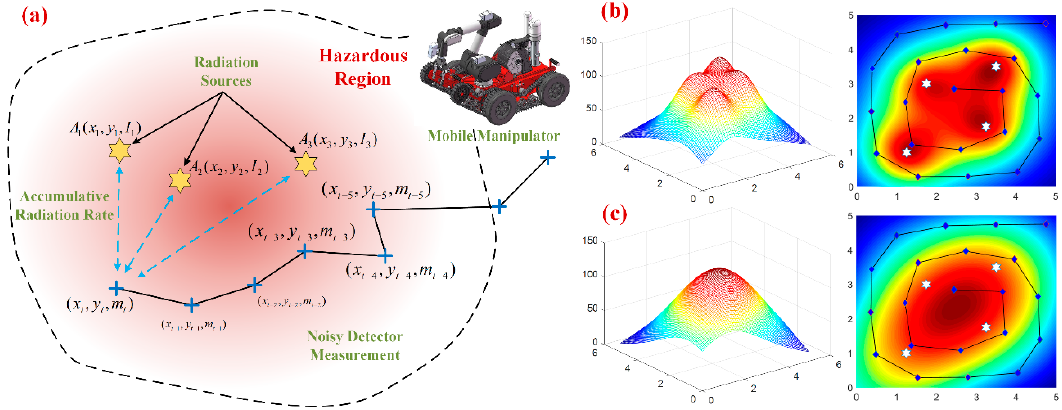
Figure 1. The multi-source radiation scene and problem illustration. ( a ) The scenario illustration of multi-source localization. ( b ) Theoretical radiation strength cloud chart for 4 radioactive sources. ( c ) Radiation strength cloud chart with simply GPs regression.